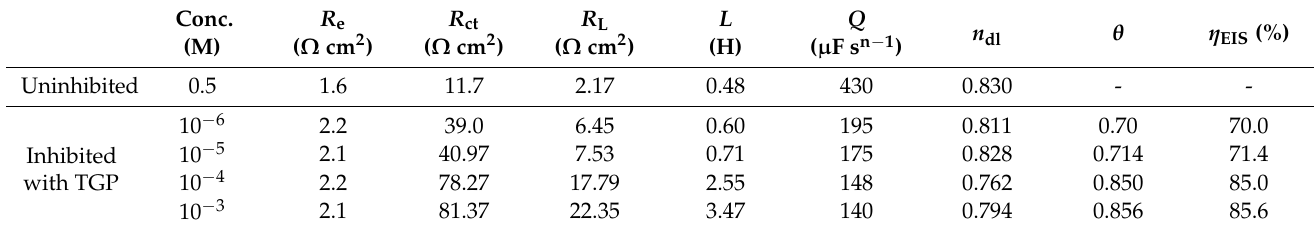
Table 2. EIS parameters for MS immersed in 0.5 M H 2 SO 4 medium, uninhibited and inhibited by different concentrations of